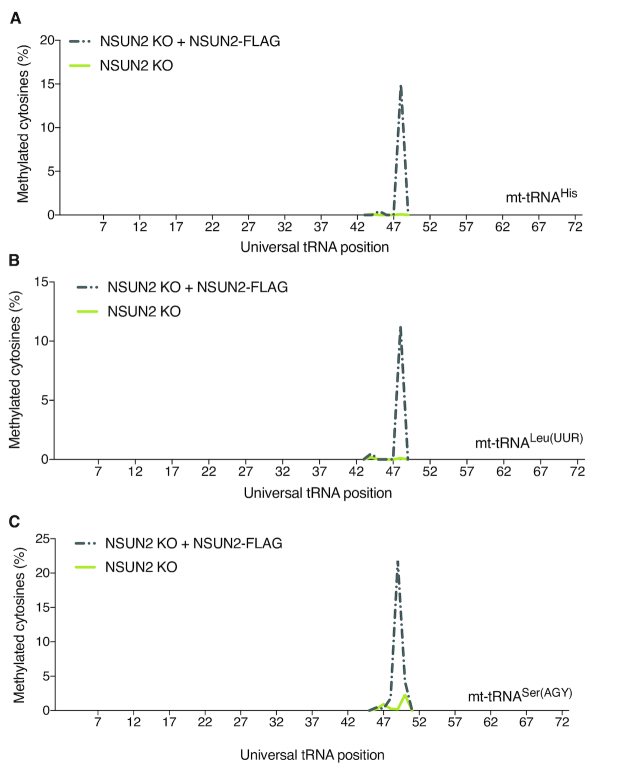
Transient expression of NSUN2 partially restores m5C in mt-tRNA. (A–C) Targeted BS RNA-Seq after transient expression of a NSUN2.FLAG.STREP2 construct in human NSUN2 KO cells. (A) Methylated cytosines of mt-tRNAHis. (B) Methylated cytosines of mt-tRNALeu(UUR). (C) Methylated cytosines of mt-tRNASer(AGY). The methylation levels have been adjusted to the percentage of the NSUN2.FLAG.STREP2 transfected cells (Supplementary Figure S3).